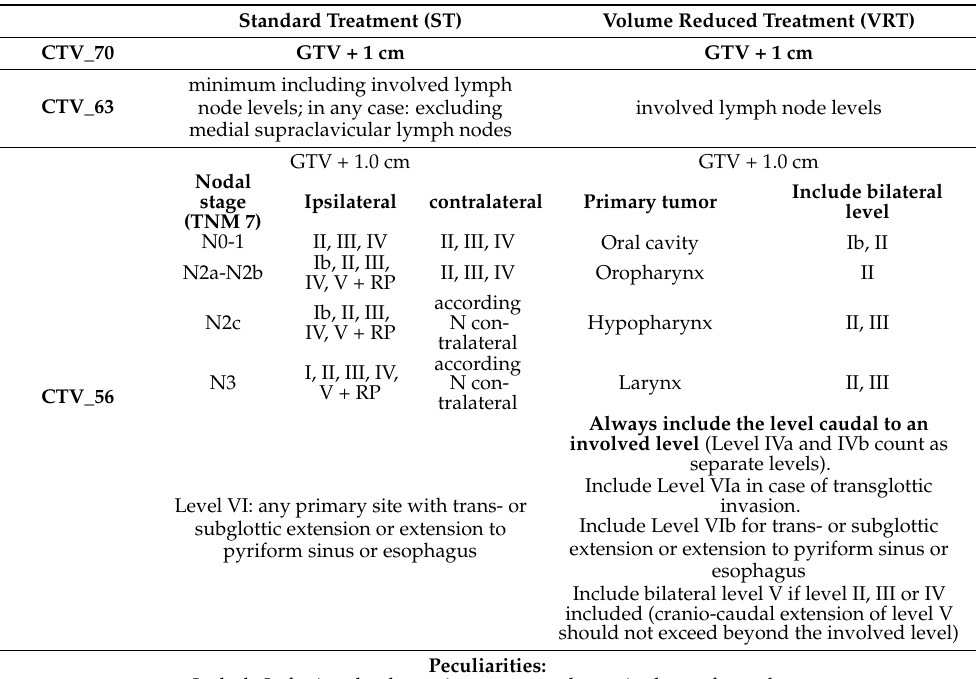
Table 1. Comparison of contouring guidelines for standard treatment (ST) and volume reduced treatment (VRT). GTV, gross tumor volume; CTV, clinical target volume; RP, retropharyngeal; RS,